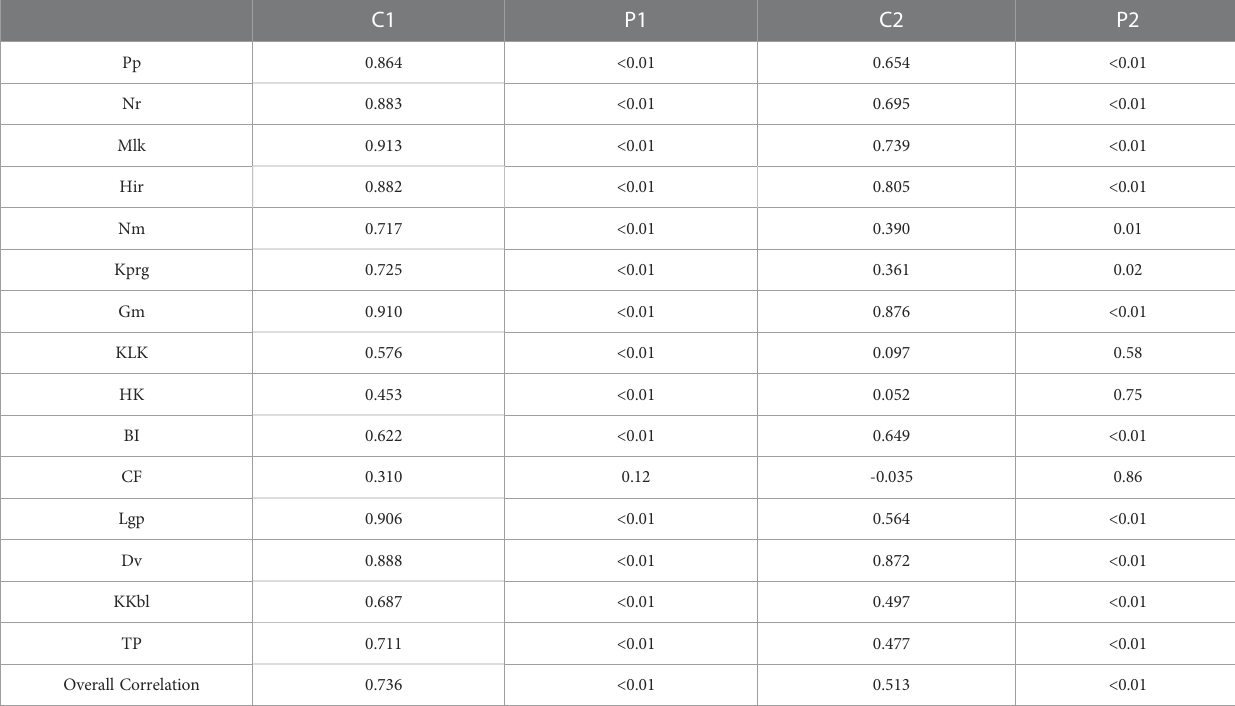
TABLE 3 Correlation coef fi cient between the ESL and mean sea level at 15 tide gauges (C1) and the correlations after getting rid of EEMD trends (C2), the P1/P2 are the p-value from t-test (where p < 0.05 means that the correlation was signi fi cant at 95% con fi dence